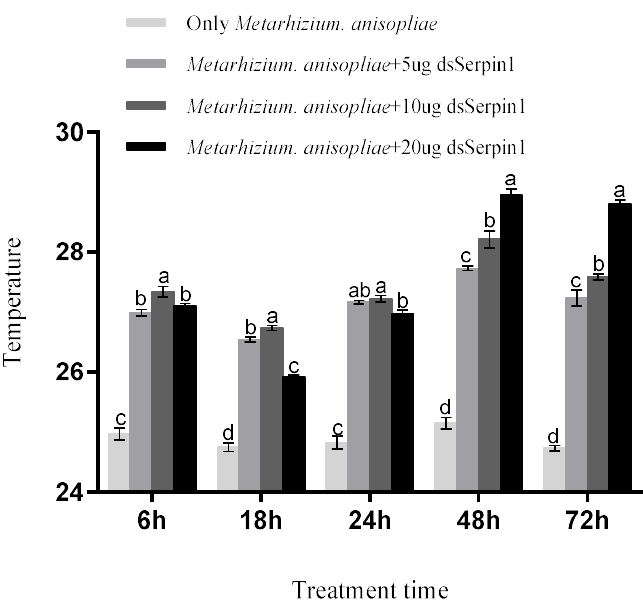
Figure 2. Temperature response of L. m. manilensis towards M. anisopliae at feeding different doses of dsSerpin1 . (There were differences between a – d representatives and other groups) 3.3. Corrected Mortality by Feeding Different Doses of dsSerpin1 and M. anisopliae The statistical analysis showed that the corrected mortality of L. m. manilensis continuously increased across the different treatments and reached over 80% without significant differences being observed regardless of dsSerpin1 dosage at day 8 ( p > 0.05, Figure 3). At day 3, the corrected mortality of the 20 µ g dsSerpin1 and M. anisopliae treatment was significantly higher than that of the treatment with M. anisopliae only (25.3% ± 3.17% vs. 4.07% ± 1.83%) There was a significant difference up to day 7. The corrected mortalities of the 10 µ g dsSerpin1 and M. anisopliae treatment were significantly higher than that of the treatment with only M. anisopliae (50.83% ± 6.63% vs. 25.09% ± 6.19%) at day 5.